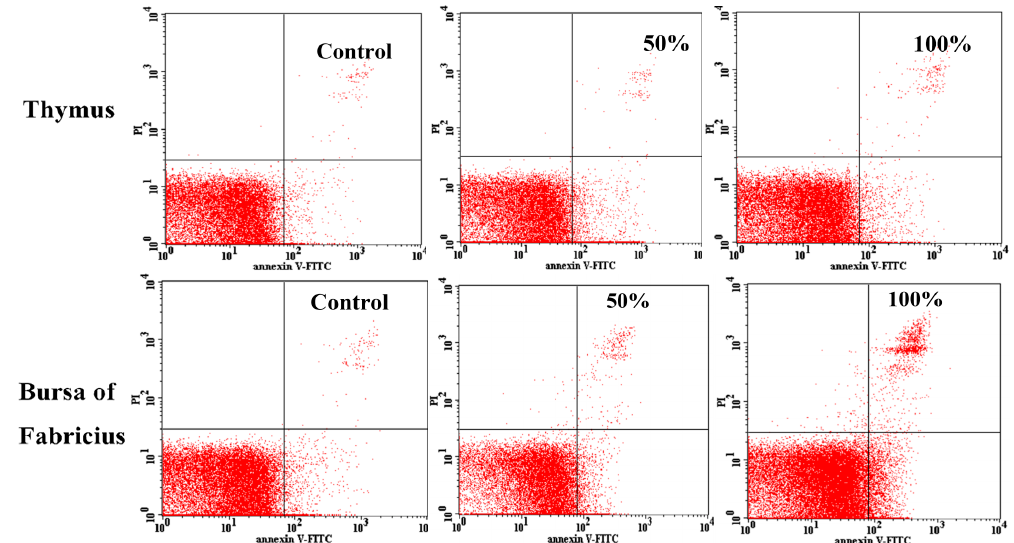
Figure 7. Cells stained positive for Annexin-V-FITC are undergoing apoptosis. Quadrantal diagram shows that increased apoptotic thymocytes and BF cells in the 50% and 100% groups are undergoing apoptosis when compared with those in the control group.